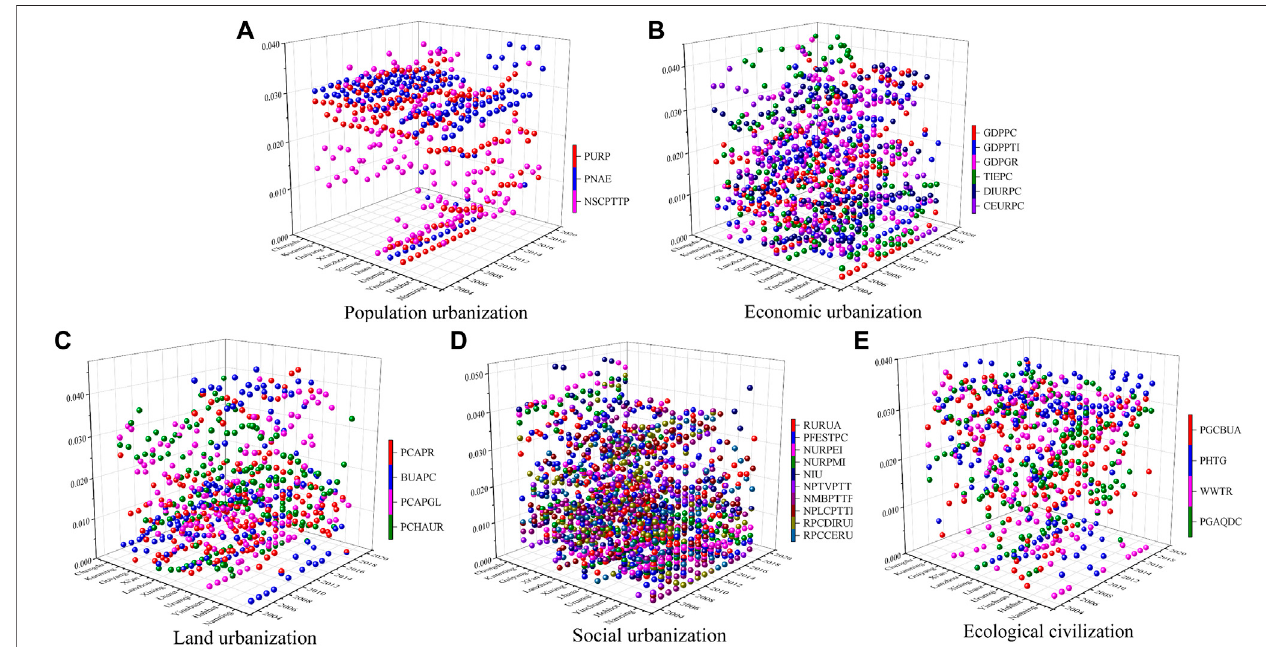
FIGURE 8 | The scores of the factor layers of each city from 2005 to 2019. (A) Population urbanization. (B) Economic urbanization. (C) Land urbanization. (D) Social urbanization. (E) Ecological civilization.